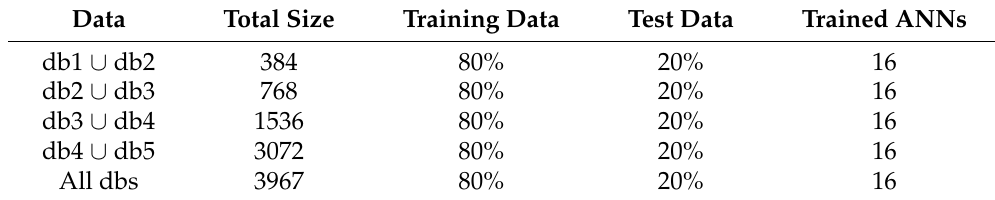
Table 2. Data for training database independence